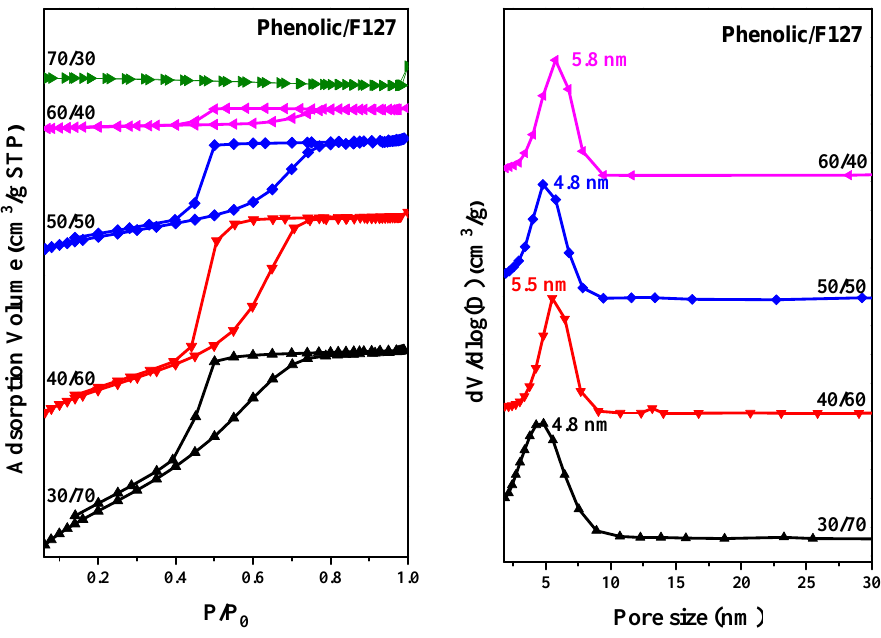
Figure 8. ( a ) N adsorption/desorption isotherms and ( b ) pore size distribution curves of 2 mesoporous phenolic templated by F127 at phenolic/F127 weight fractions of 30/70, 40/60, 50/50, 60/40 and 70/30.